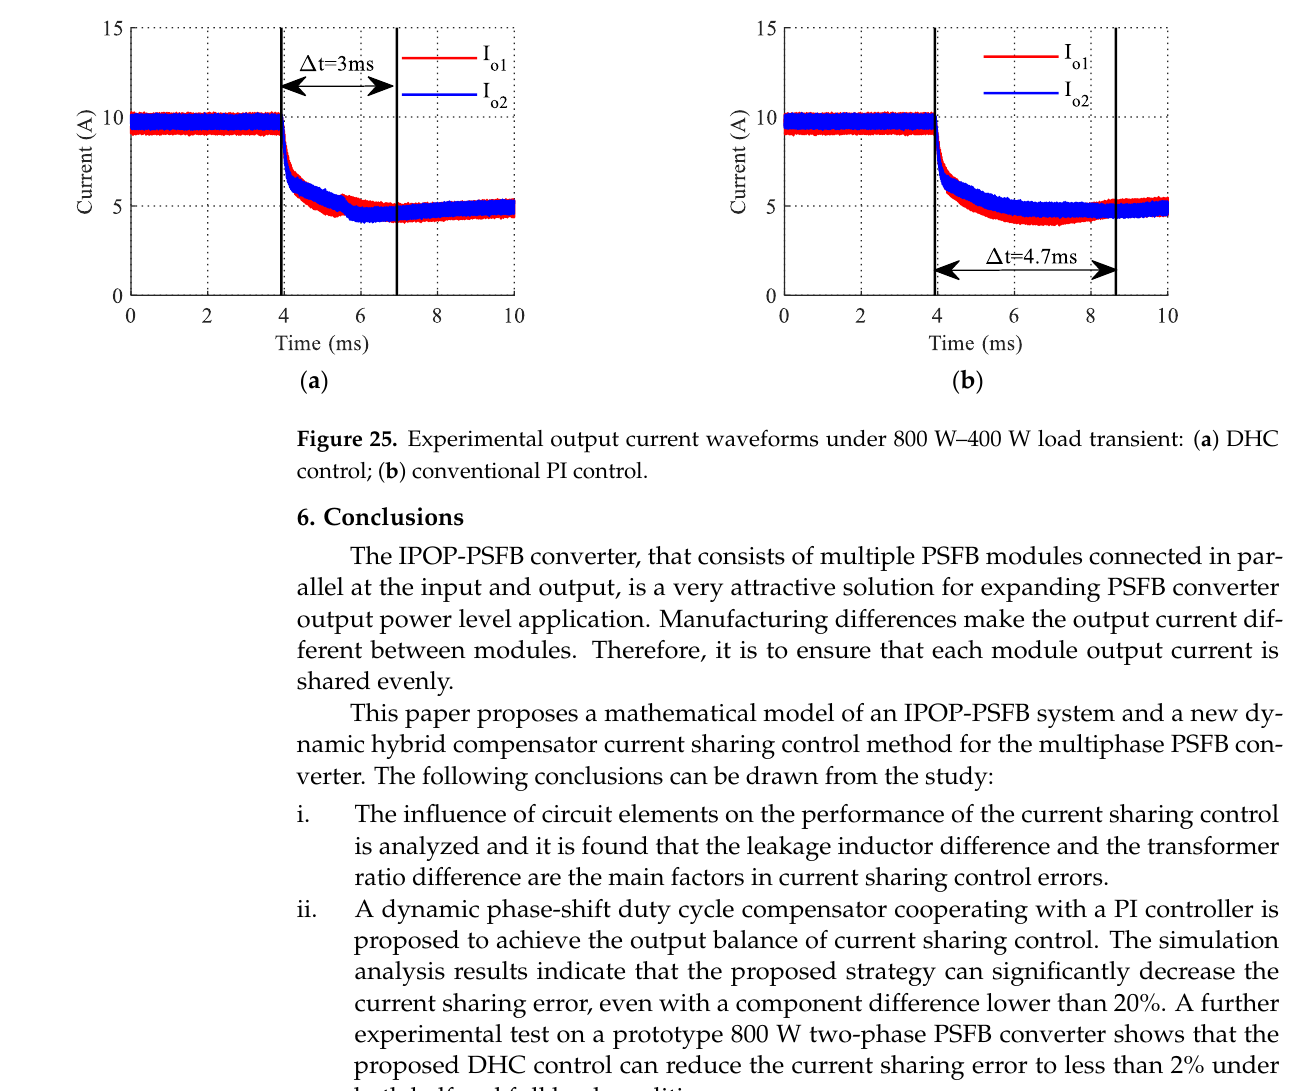
22 of 24 the PI control, the dynamic response time of the DHC control is 1.7 ms faster than the PI control, showing a 36.2% improvement. ( a ) ( b ) ( c ) Figure 24. Experimental result of output current after using DHC: (a) o R = 4  , o P = 400 W; (b) o R = 2.667  , o P = 600 W; (c) o R = 2  , o P = 800 W. Table 13. Experimental data after using DHC. o P